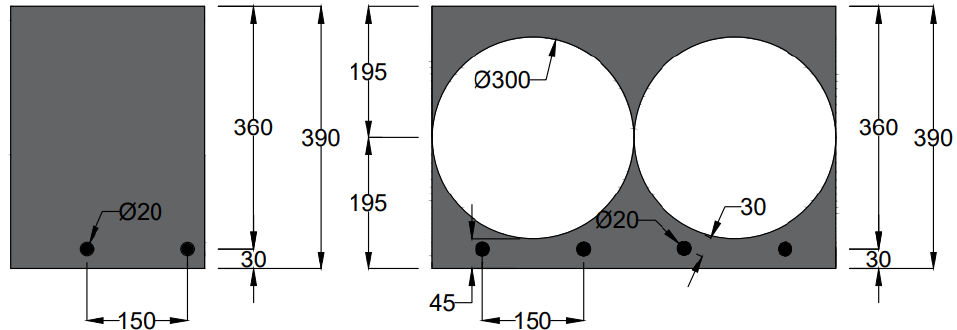
Figure 7. Cross-sections of the solid and hollow sphere slabs dimensioned according to [5] (all dimensions in mm).